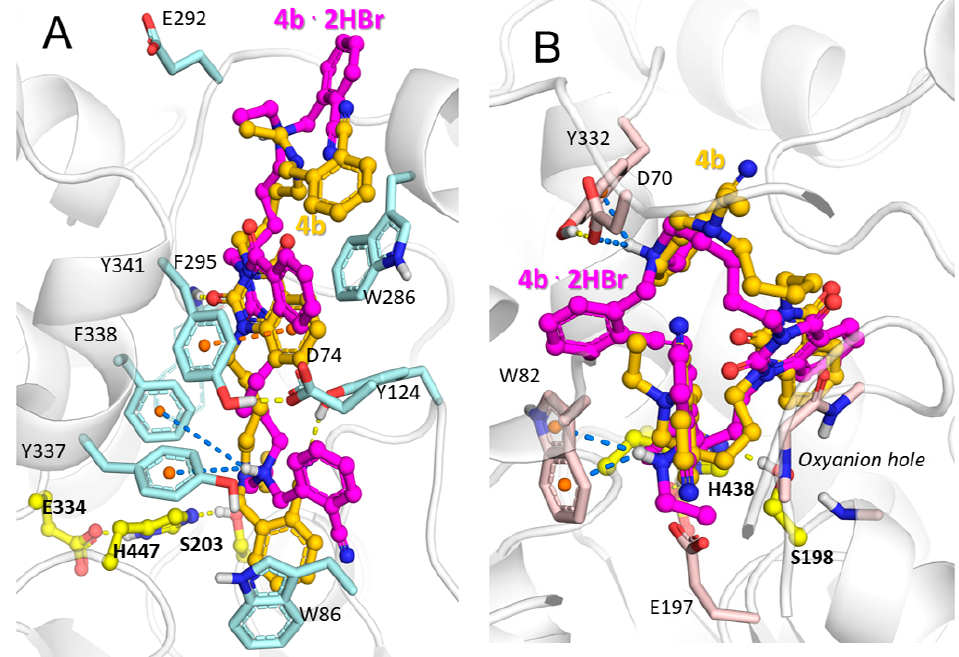
Figure 3. Binding poses of quinazoline-2,4-dione 4b (carbon atoms are shown gold) and its charged counterpart 4b· 2HBr (carbon atoms are shown in magenta) inside active site gorges of ( A ) hAChE and ( B ) hBChE. Yellow, dashed lines represent hydrogen bonds, orange represents π – π stacking interactions, and blue lines are ionic and π –cation interactions. The catalytic triads of the enzymes are shown with yellow carbon atoms. Molecules 2020 , 25 , x FOR PEER REVIEW